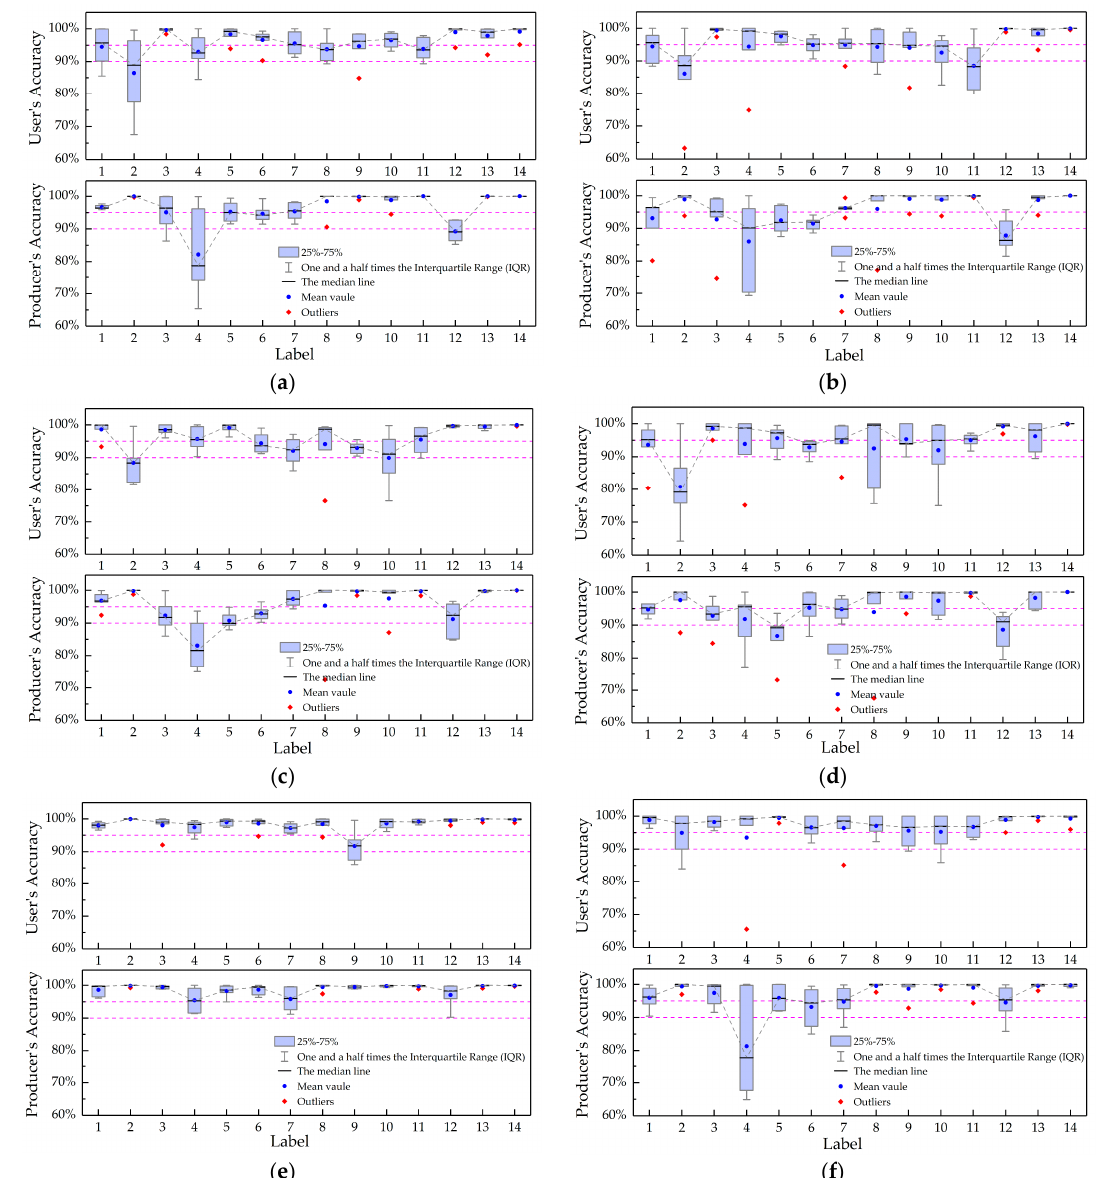
Figure 6. Boxplots of user’s accuracy and producer's accuracy for each dataset: ( a ) AHSI_10 m; ( b ) AHSI_30 m; ( c ) AHSI_SW_10 m; ( d ) AHSI_SW_30 m; ( e ) SASI_2.25 m; ( f ) SASI_10 m.